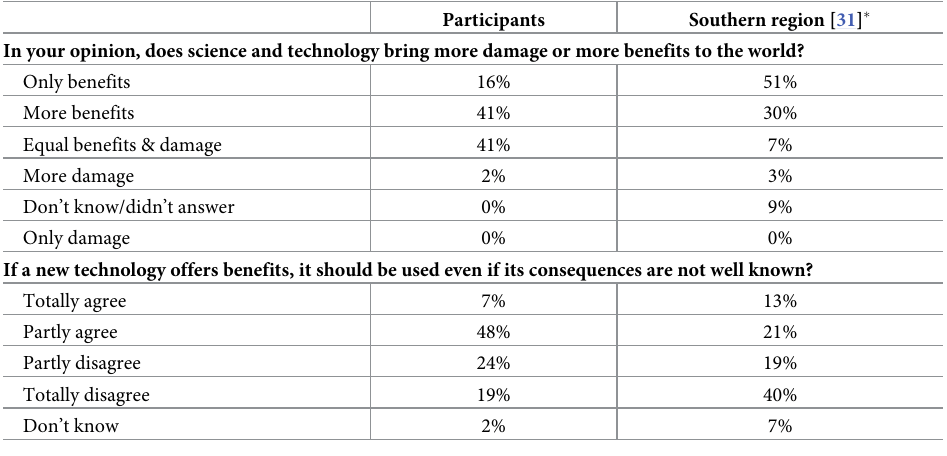
Table 2. Participants position on damages and benefits of science and technology and their position on whether the technology should be used despite no available knowledge regarding its long-term consequences (n = 570). In your opinion, does science and technology bring more damage or more benefits to the world?